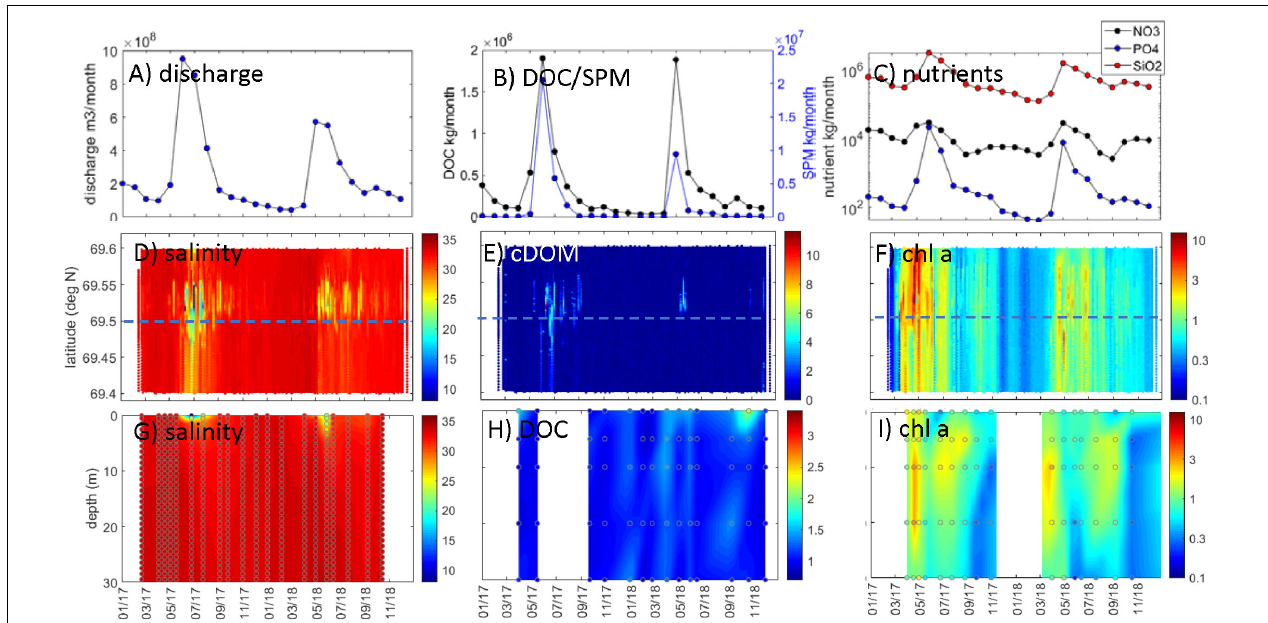
FIGURE 7 | Malangen/northern Norway observations. Målselv river: (A) discharge (m 3 month − 1 ), (B) DOC transport (kg month − 1 ) and SPM transport (kg month − 1 ), and (C) nutrient transport (kg month − 1 ; black: NO 3 -N, blue: PO 4 -P, red: SiO 2 -Si). FerryBox observations within < 1 km of coastal station: (D) salinity, (E) cDOM fluorescence (arbitrary), and (F) chl a ( µ g L − 1 ; log scale). Water column station data [comparable latitude indicated by dashed blue line in panels (D–F) ]: (G) salinity, (H) DOC (mg L − 1 ), and (I) chl a ( µ g L − 1 ; log scale). Data in panels (D–I) were interpolated with actual data points